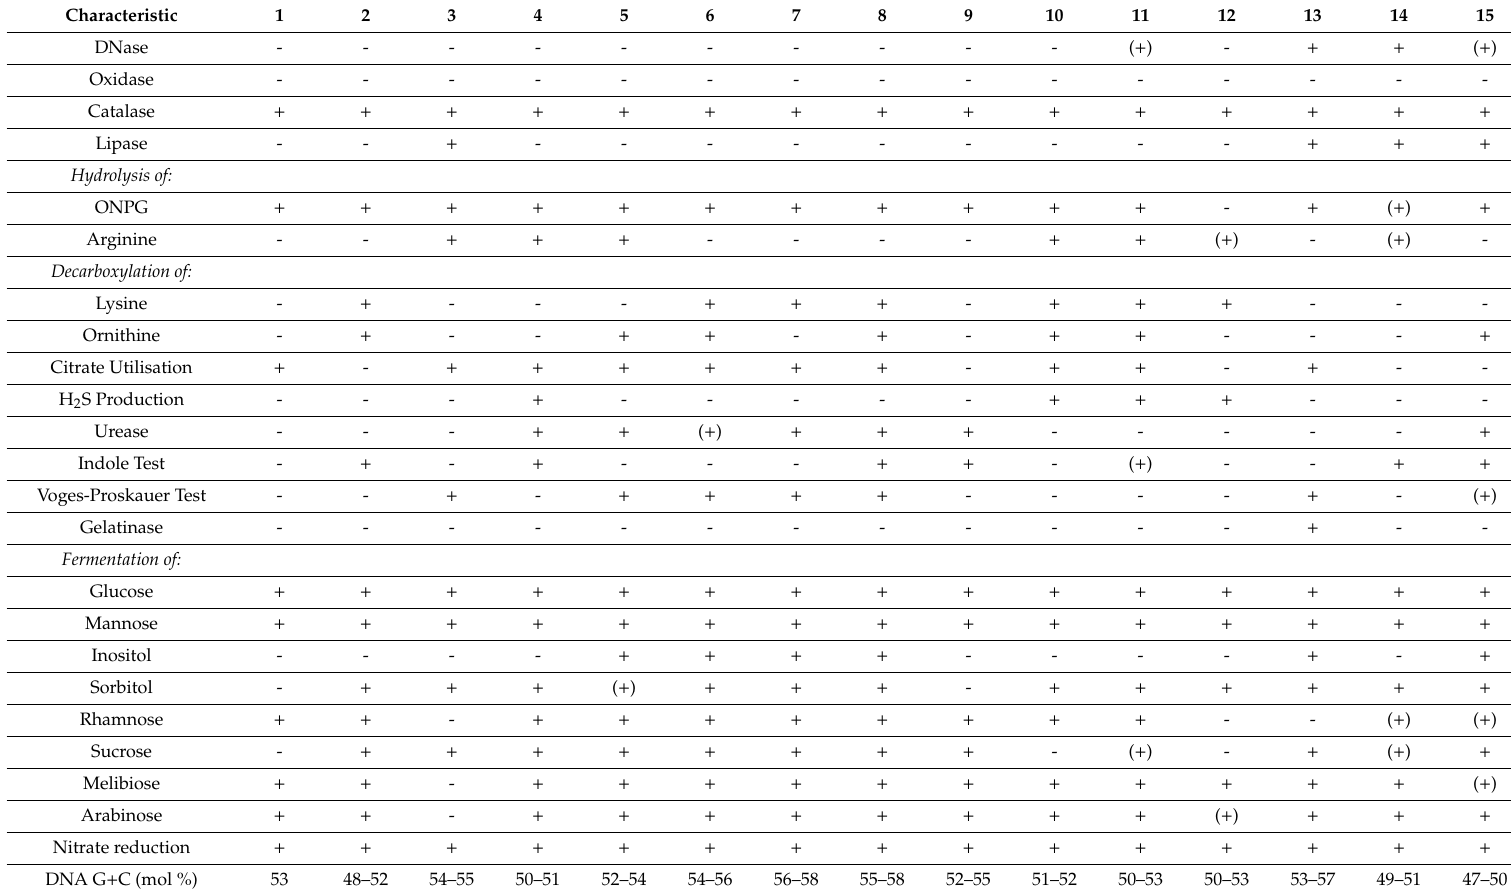
Table 2. Comparison of phenotypic characteristics of strain ZA_0188 T and closely related Enterobacteriaceae species. Taxa: 1: Strain ZA_0188; 2: E. coli ; 3: Cedecea neteri ; 4: Citrobacter freundii ; 5: Enterobacter cloacae ; 6: Enterobacter aerogenes ; 7: Klebsiella pneumoniae ; 8: Klebsiella oxytoca ; 9: Leclercia adecarboxylata ; 10: Salmonella bongori ; 11: Salmonella enterica subsp. arizonae; 12: Salmonella enterica serovar Typhi; 13: Serratia plymuthica ; 14: Shigella flexneri ; 15: Yersinia enterocolitica . + : positive result; ( + ) : weak positive result (below 20%); - : negative result. Reference taxa data were taken from Farmer